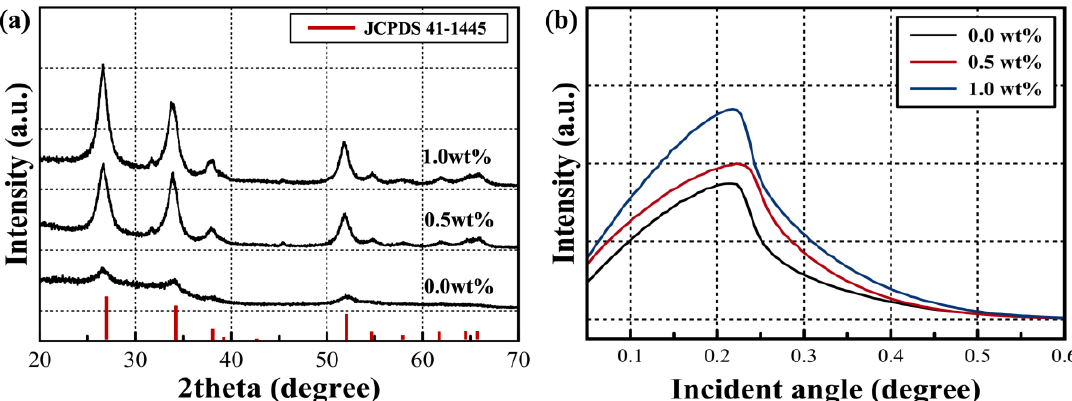
Figure 1. ( a ) The GIXRD spectra and ( b ) X-ray reflectivity curves for solution-processed SnO 2 films doped with 0.0 (Pristine), 0.5 and 1.0 wt% Mg.